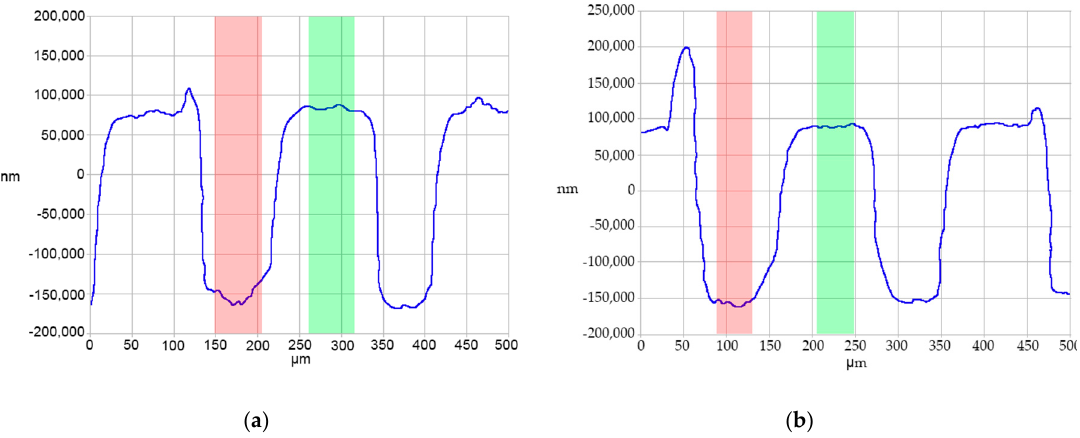
Figure 12. Contact profilometry traces of damaged Group A channels from Tool 4 parts ( a ) 25 and ( b ) 30.